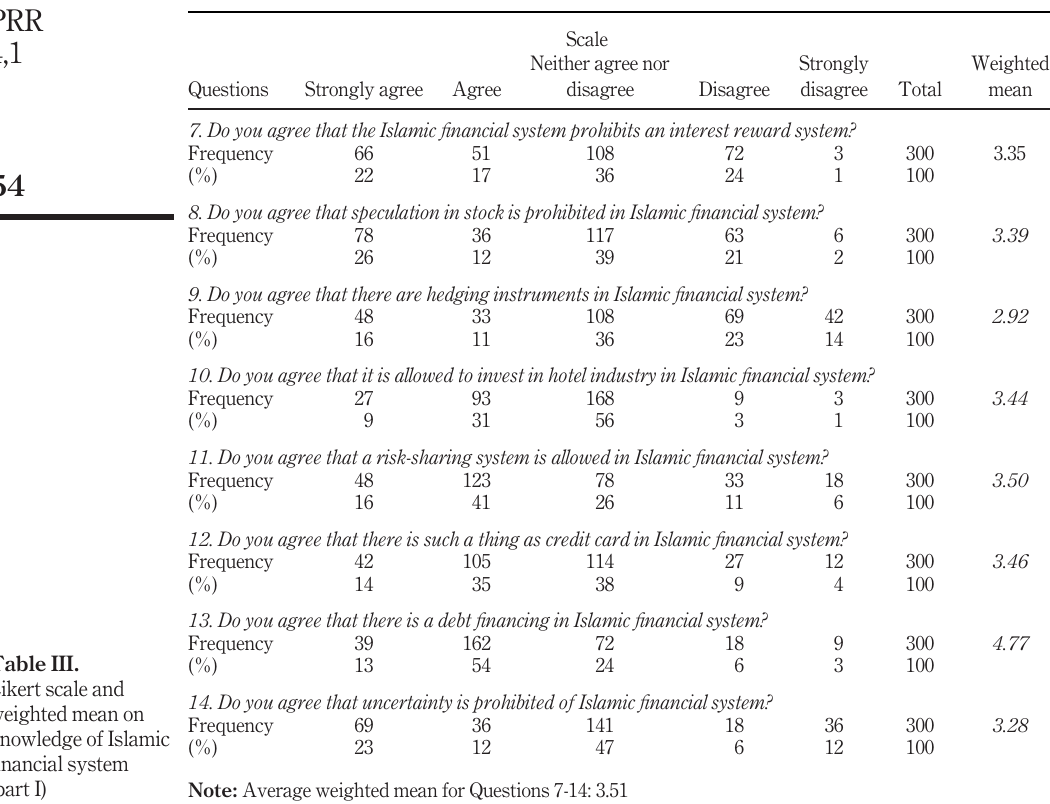
weighted mean on knowledge of Islamic fi nancial system (part